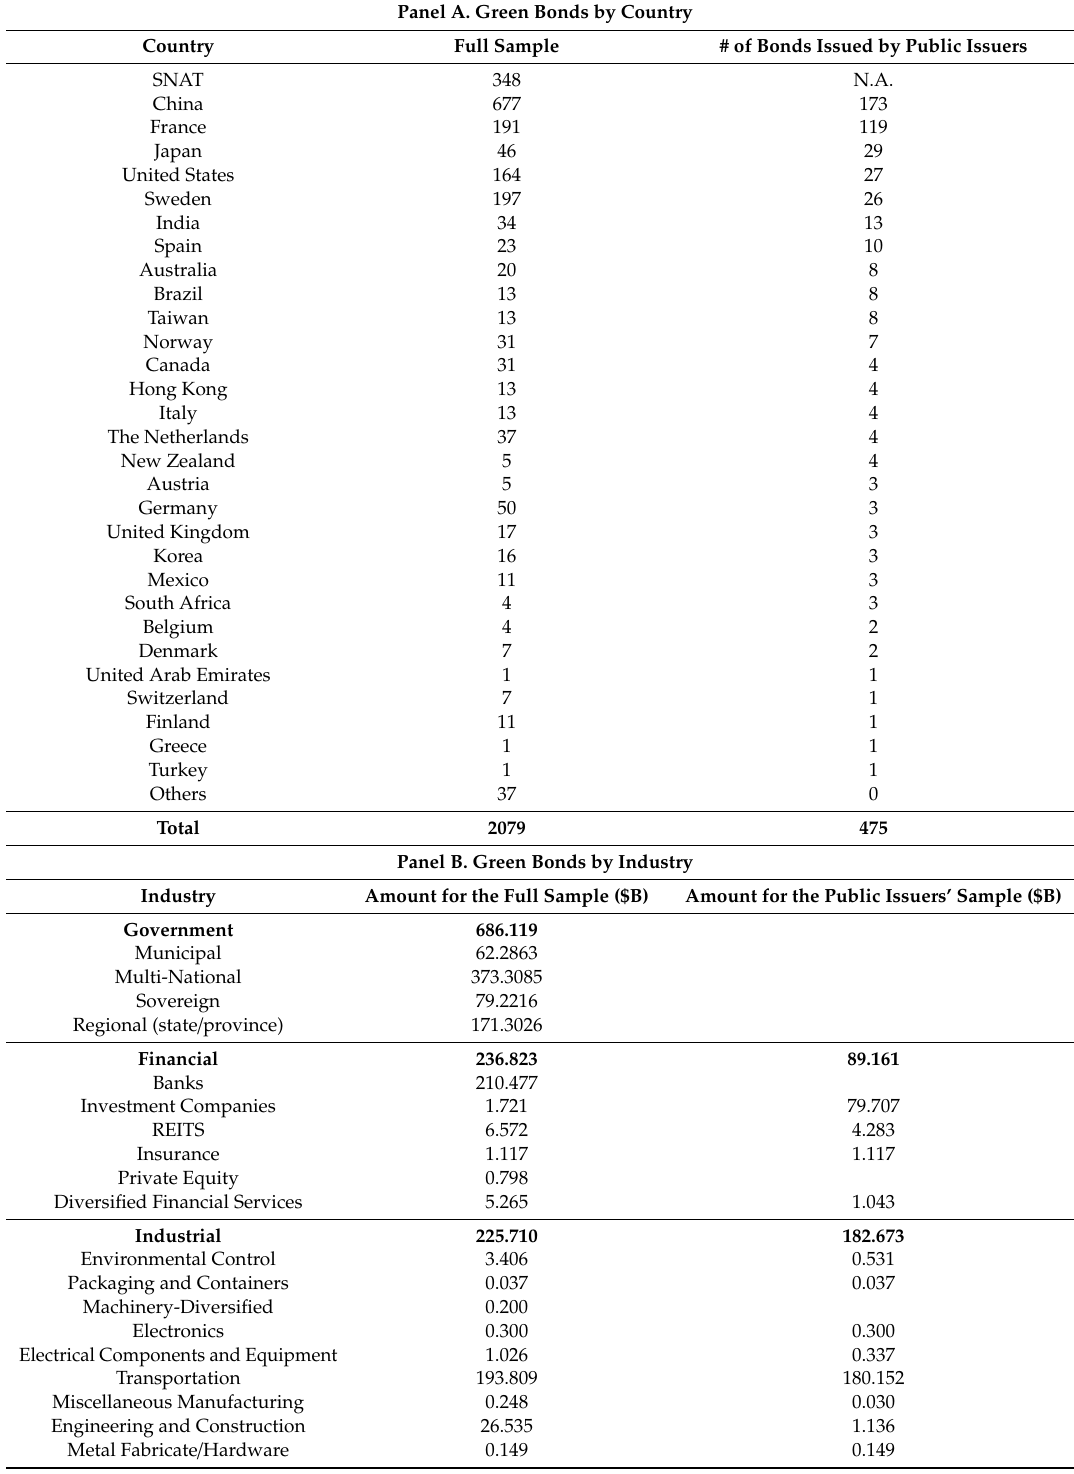
Table 1. Green bond samples. Panel A. Green Bonds by